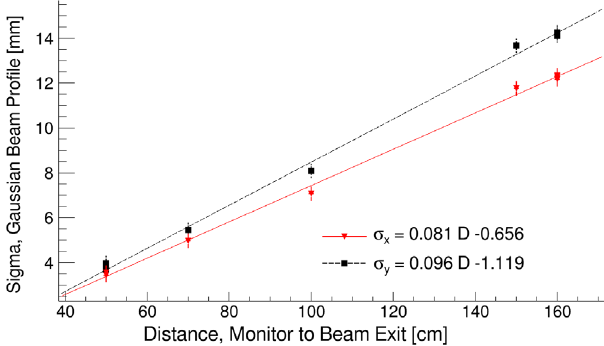
FIG. 24. Beam spread measured by IC 2 D along x and y as a function of the distance from the beam pipe exit window (the distance traveled in air by the beam); reported σ x and σ y from the Gaussian fit (as in Fig. 22).